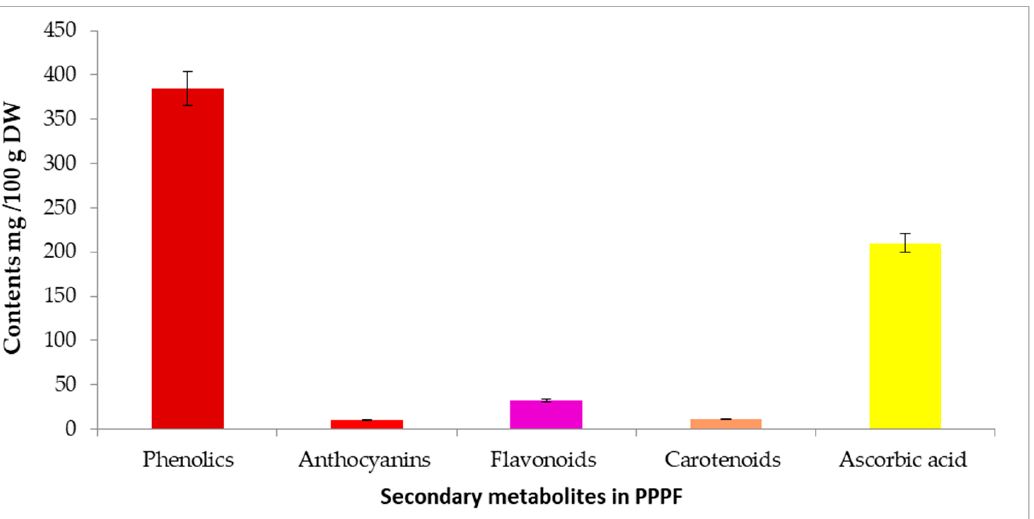
Figure 1. Secondary metabolites contents (Total phenolic mg GAE/100 g, total anthocyanins mg KE/100 g, total flavonoids mg QE/100 g, total carotenoids, and ascorbic acid) in PPPF. Each value represents the mean (±SD) of three different replications. GAE: gallic acid; KE: kuromanin; QE: quercetin.